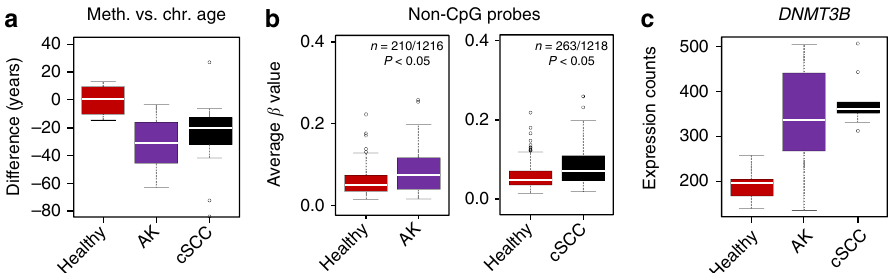
Fig. 3 AK and cSCC display typical features of stem cell methylomes. a Mean difference between chronological and methylation-based biological age for healthy, AK, and cSCC samples. b Box plots indicating the average methylation levels of the 210 (left panel) and 263 (right panel) differentially ( P < 0.05, F -test) methylated non-CpG probes in AK and cSCC. c The DNA methyltransferase DNMT3B gene is signi fi cantly upregulated in AK ( P < 0.002, two-sided t -test) and cSCC ( P < 3.43E − 06, two-sided t -test). RNA-seq gene expression data from 7 healthy, 10 AK, and 9 cSCC epidermis samples was obtained from Chitsazzadeh et al.